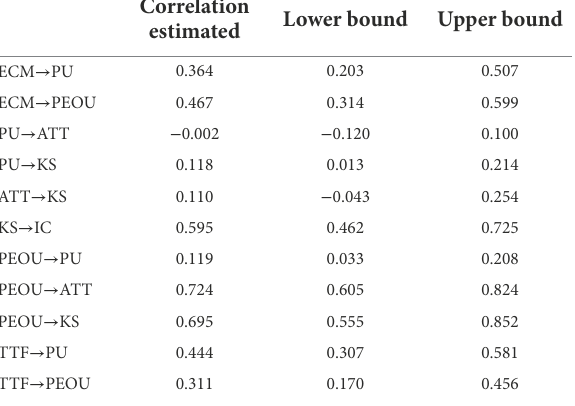
TABLE 4 Bootstrapping for examining discriminant validity.